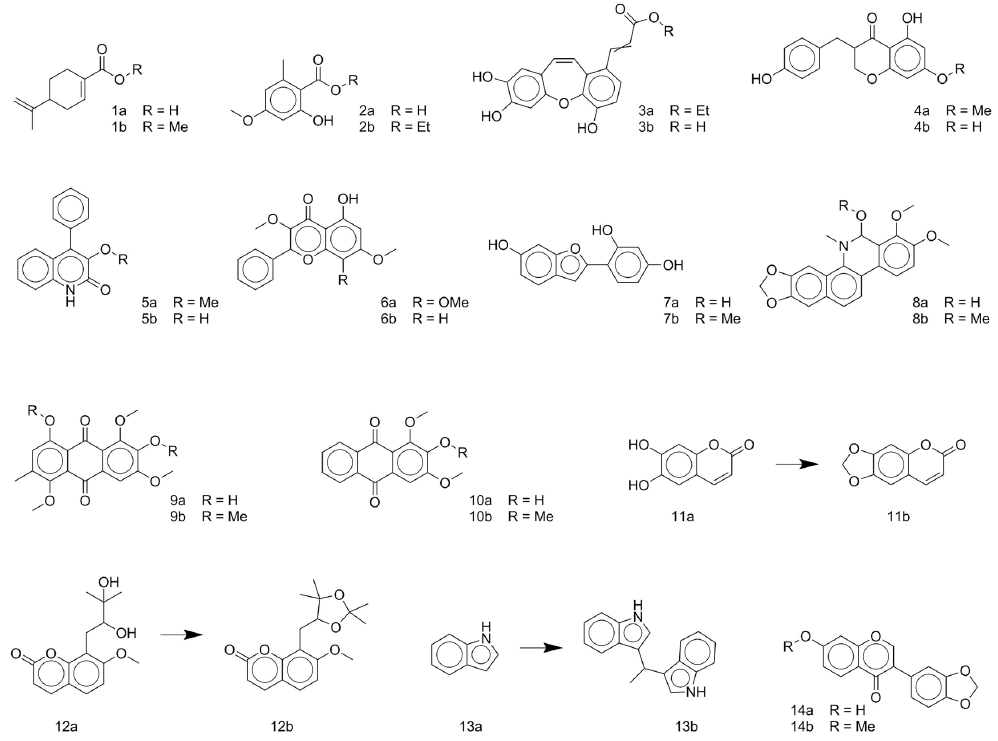
Figure 3. Some typical cases of reactive natural products and their probable artifacts caused by solvolysis in the result data set.